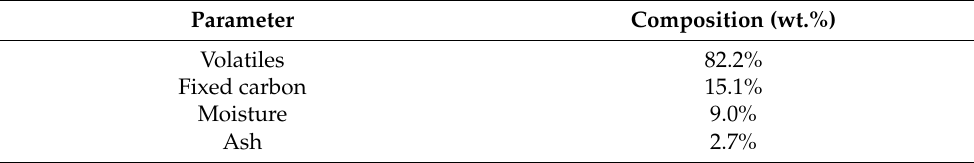
Table 2. Biomass characterization on dry basis